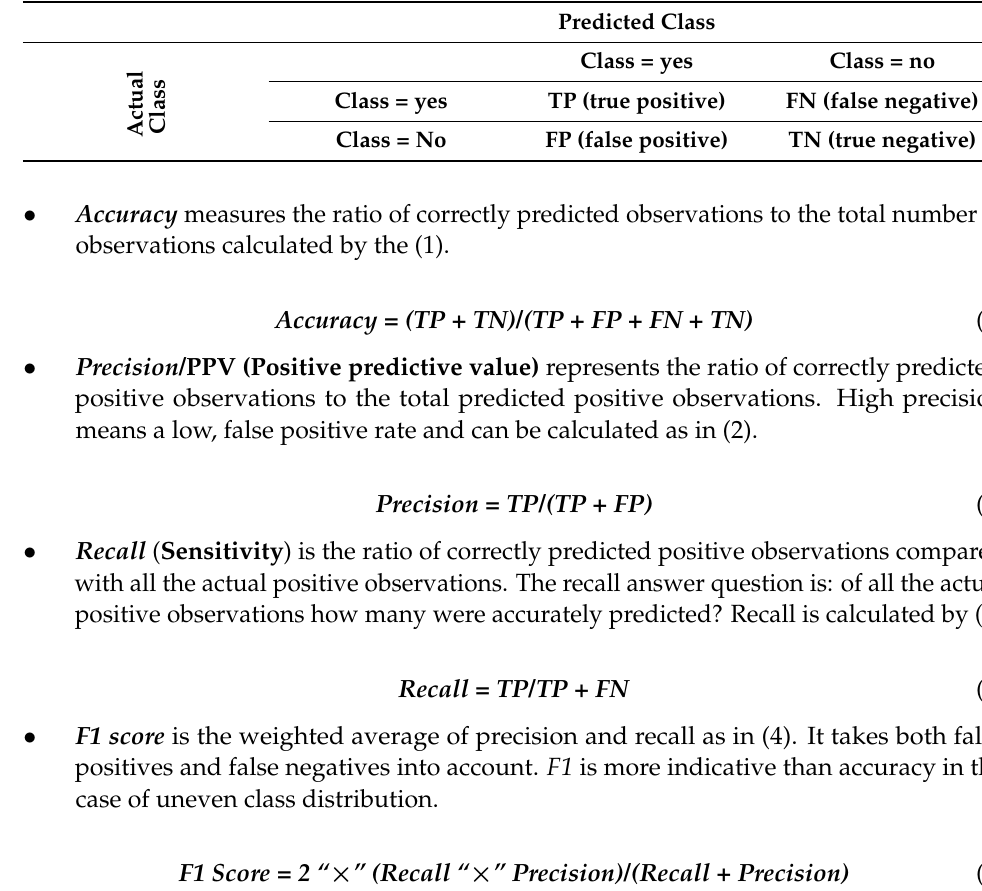
Table 4. Performance evaluation